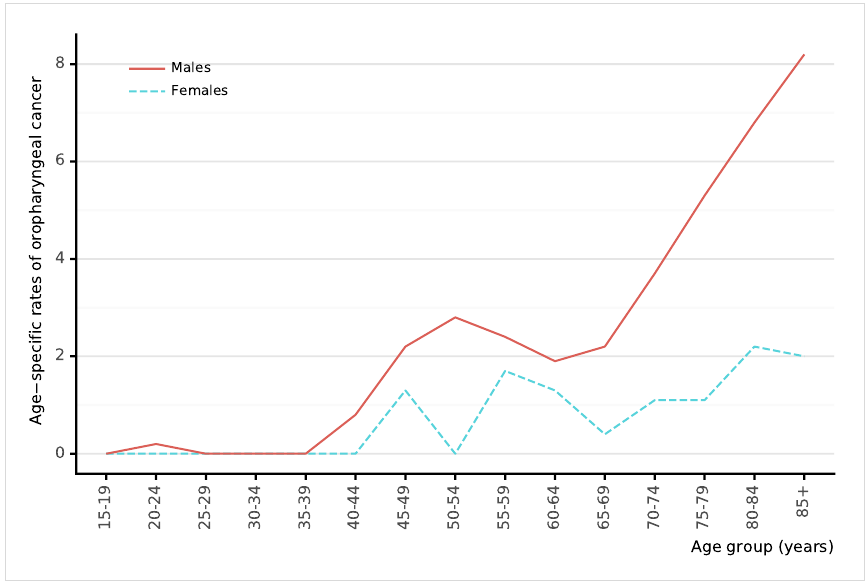
Figure 36: Age-specific incidence rates of oropharyngeal cancer in Peru (estimates for 2020)